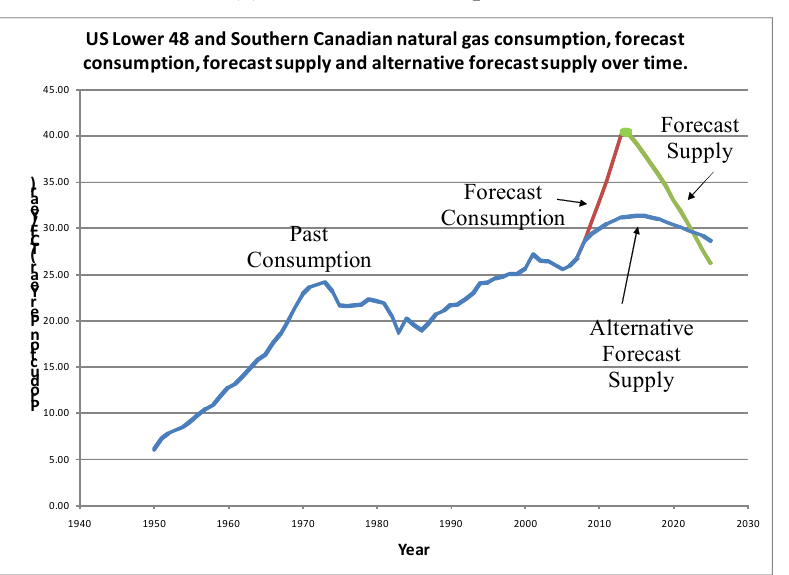
Figure 6. (a) Forecast consumption over